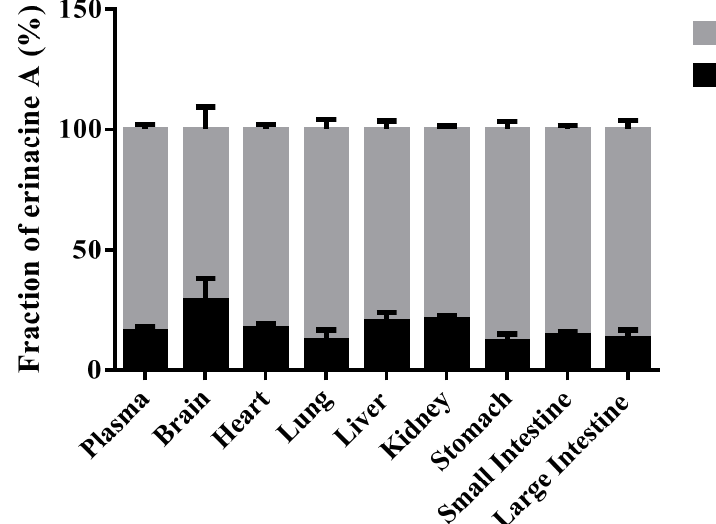
Figure 5. Fraction unbound and bound erinacine A in plasma and diluted (4 × ) tissue homogenates (brain, heart, lung, liver, kidney, stomach, large intestine, and small intestine) determined using the rapid equilibrium dialysis devices with 8000 Da molecular weight cut-off and analyzed by LC-MS/MS (n = 3). Data are presented as mean ± SD.